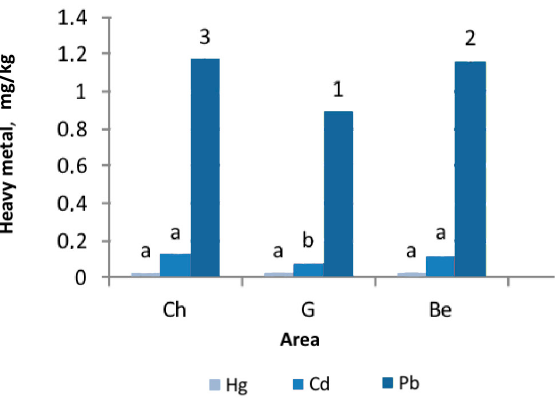
Figure 2 Heavy metal levels in muscle tissue of farmed rainbow trout from three aquaculture sites (G: site A; Be: site B; Ch: site C). All results are expressed as means ± SD for five fish in each group. a and b: groups with different letters differ significantly ( P < 0.05)